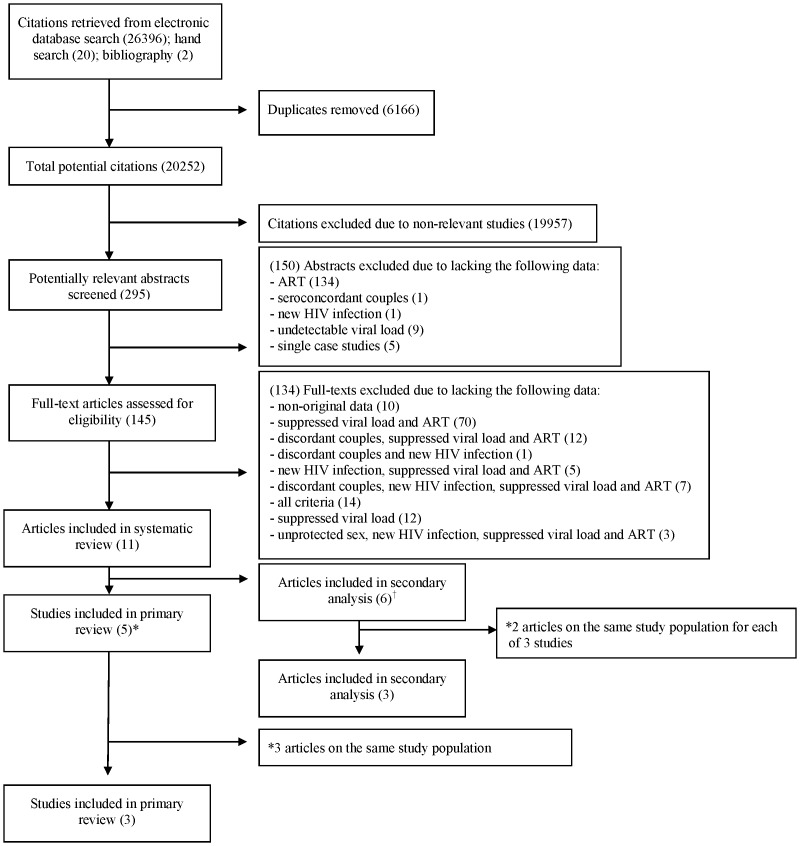
Flow diagram (selection strategy) of included studies.